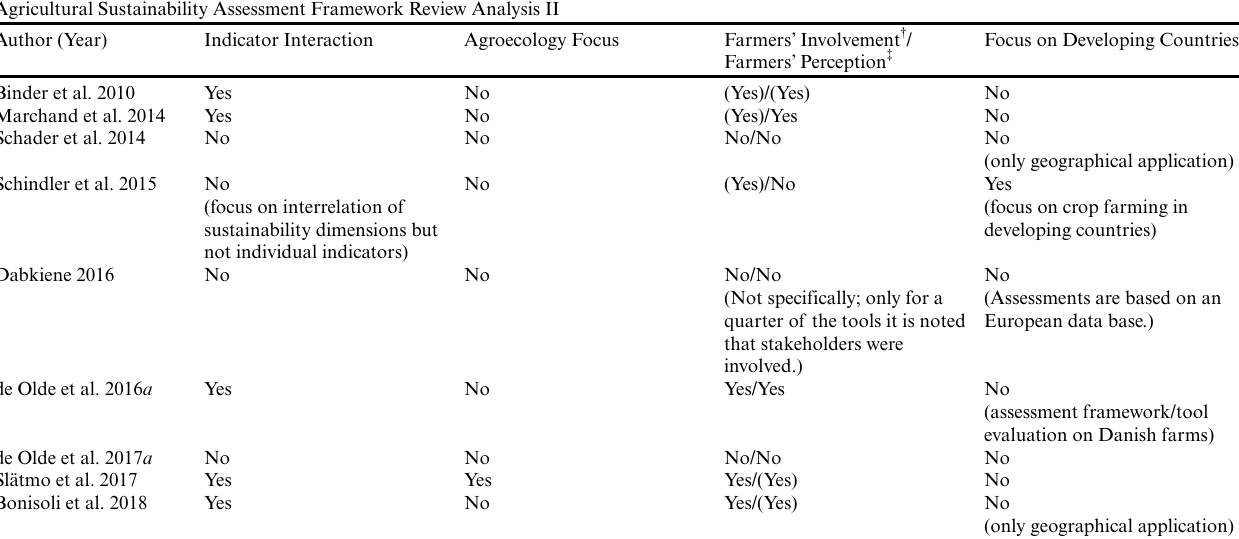
Table 2 . Review analysis II. Evaluation criteria of the analysis of agricultural sustainability assessment framework reviews were the implementation of indicator interaction analyses, the assessment frameworks’ emphasis on agroecological farming systems (AFSs), the farmers’ involvement in the development process of the frameworks, the farmers’ perception of the utility and suitability of the frameworks, and the frameworks’ emphasis on agricultural systems in developing